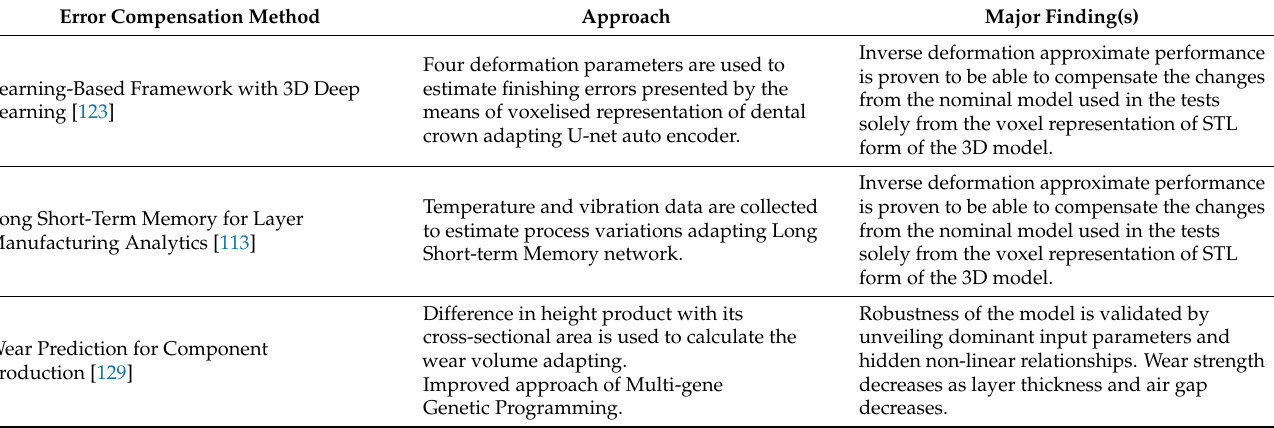
Table 5. Summary for error compensation methods in additive